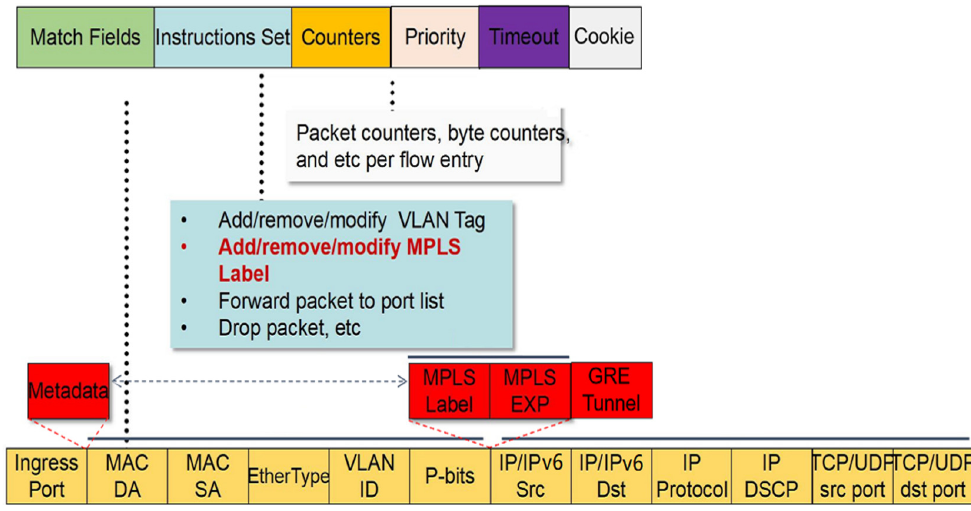
Figure 1. OpenFlow1.3 flow table structure.